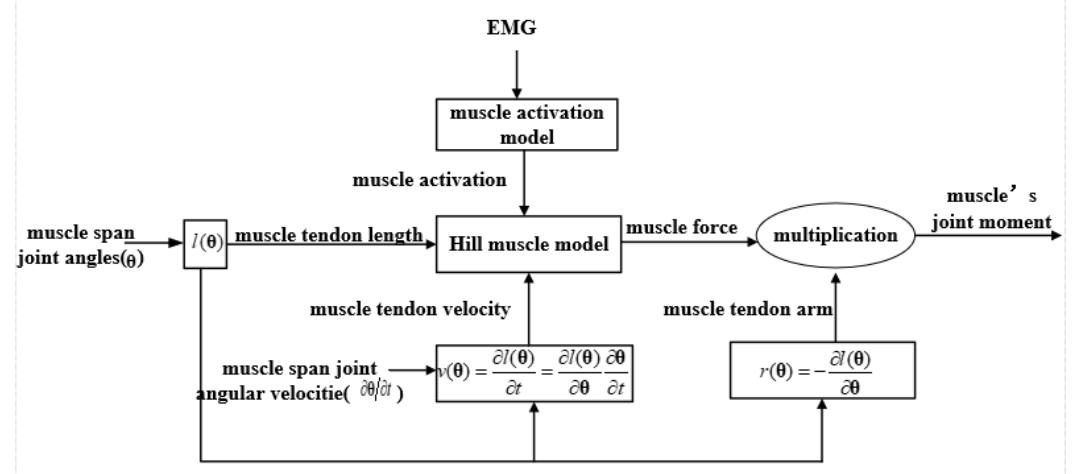
Figure 1. Data processing pipeline of the method based on Hill muscle model, where l ( θ ) is a polynomial function of the muscle spans joint angles.